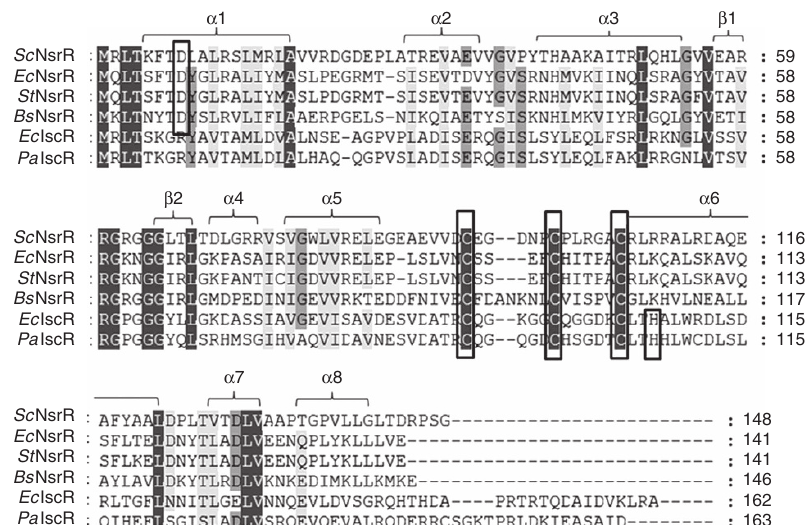
Figure 1 | Amino acid alignment of S. coelicolor NsrR with related proteins. Other shown NsrRs are from E. coli (EcNsrR), Salmonella enterica typhimurium (StNsrR) and B. subtilis (BsNsrR). IscR proteins are from E. coli (EcIscR) and P. aeruginosa (PaIscR). The alignment was carried out using Clustal Omega 45 and presented using Genedoc 46 . Secondary structural elements of ScNsrR are indicated above the sequences. Residues that serve as cluster ligands in NsrR and IscR are indicated by boxes. Black colour indicates totally conserved residues, grey indicates highly conserved residues, and light grey indicates residues that are either well conserved or conservatively substituted.